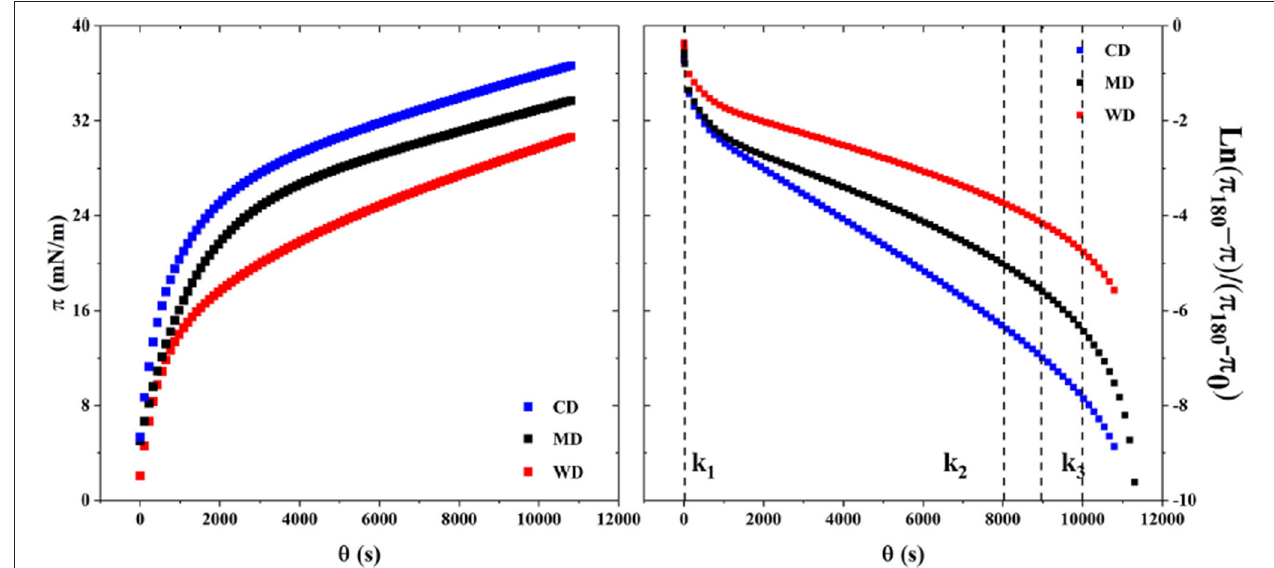
FIGURE 3 | Time evolution of surface pressure for quinoa hyperprotein-defatted flour adsorbed at the air/water interface at pH 7 and I 0.05M.